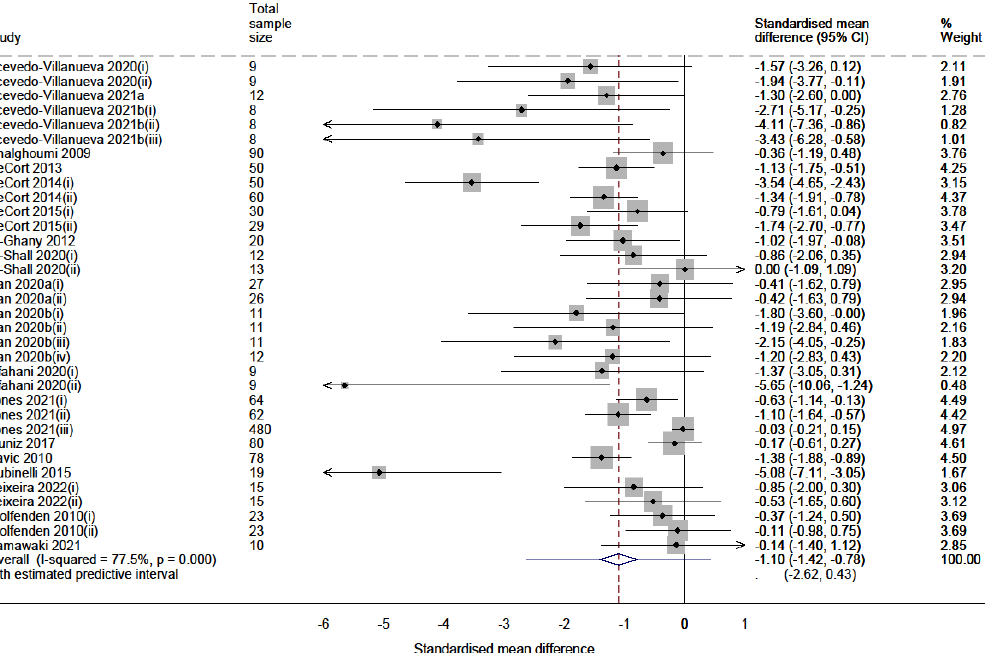
Figure 3. Random effects meta-analysis forest plot synthesising the effects of vaccinating meat chickens against Salmonella [48–66]. Each point represents the calculated SMD of each comparator with whiskers representing the 95% confidence interval. Each box represents the weight percentage that each study contributes to the final pooled estimate. The middle of the diamond (bottom) represents the pooled estimate, and the sides represent its 95% confidence interval. The whiskers at either side of the diamond represent the estimated predictive interval.